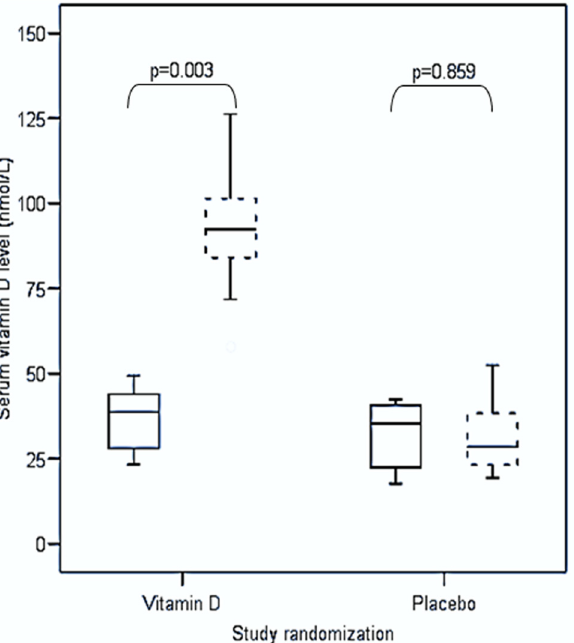
Fig 2. Differences in median serum vitamin D levels among women with former GDM in both groups. Boxplot with complete line = Pre-study serum vitamin D level. Boxplot with breaking line = Post-study serum vitamin D